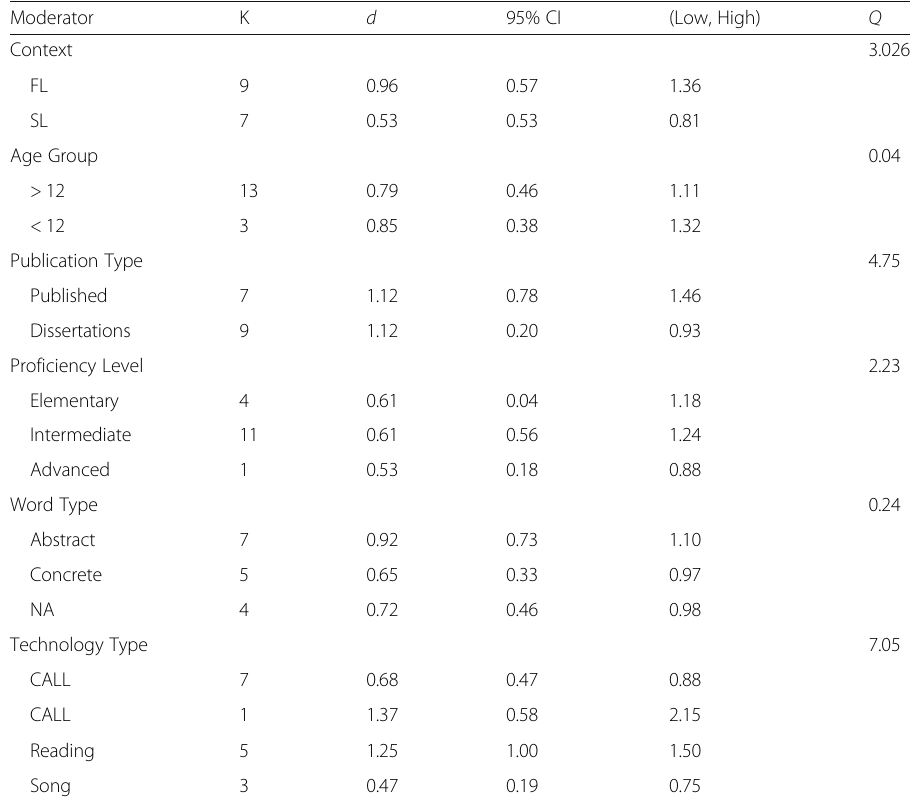
Table 4 Moderator analysis: Means and Q-statistics for group contrasts